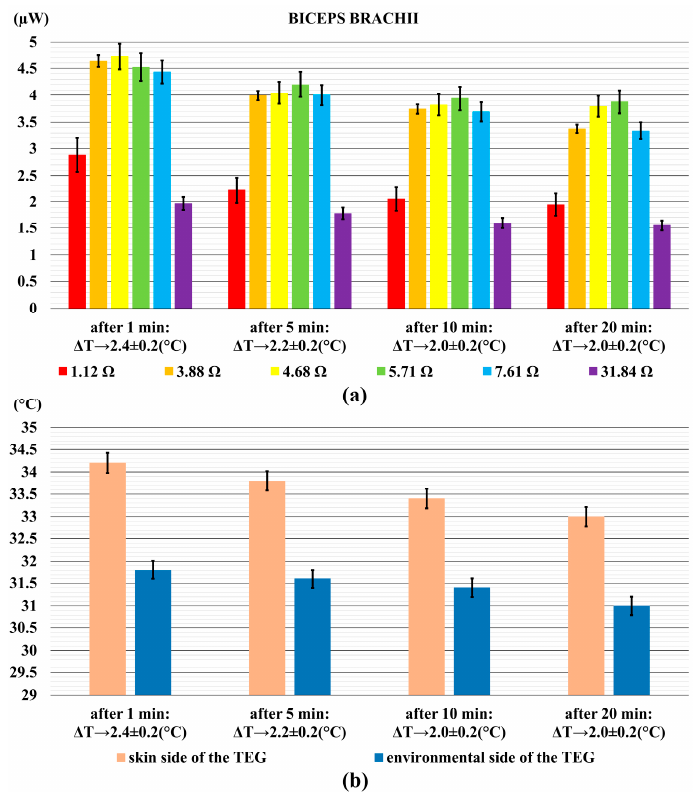
Figure 4. The power output generated by the TEG on the anterior arm anterior (biceps brachii) ( a ); and the relative temperature difference ( b ). Error bars represent standard deviations.